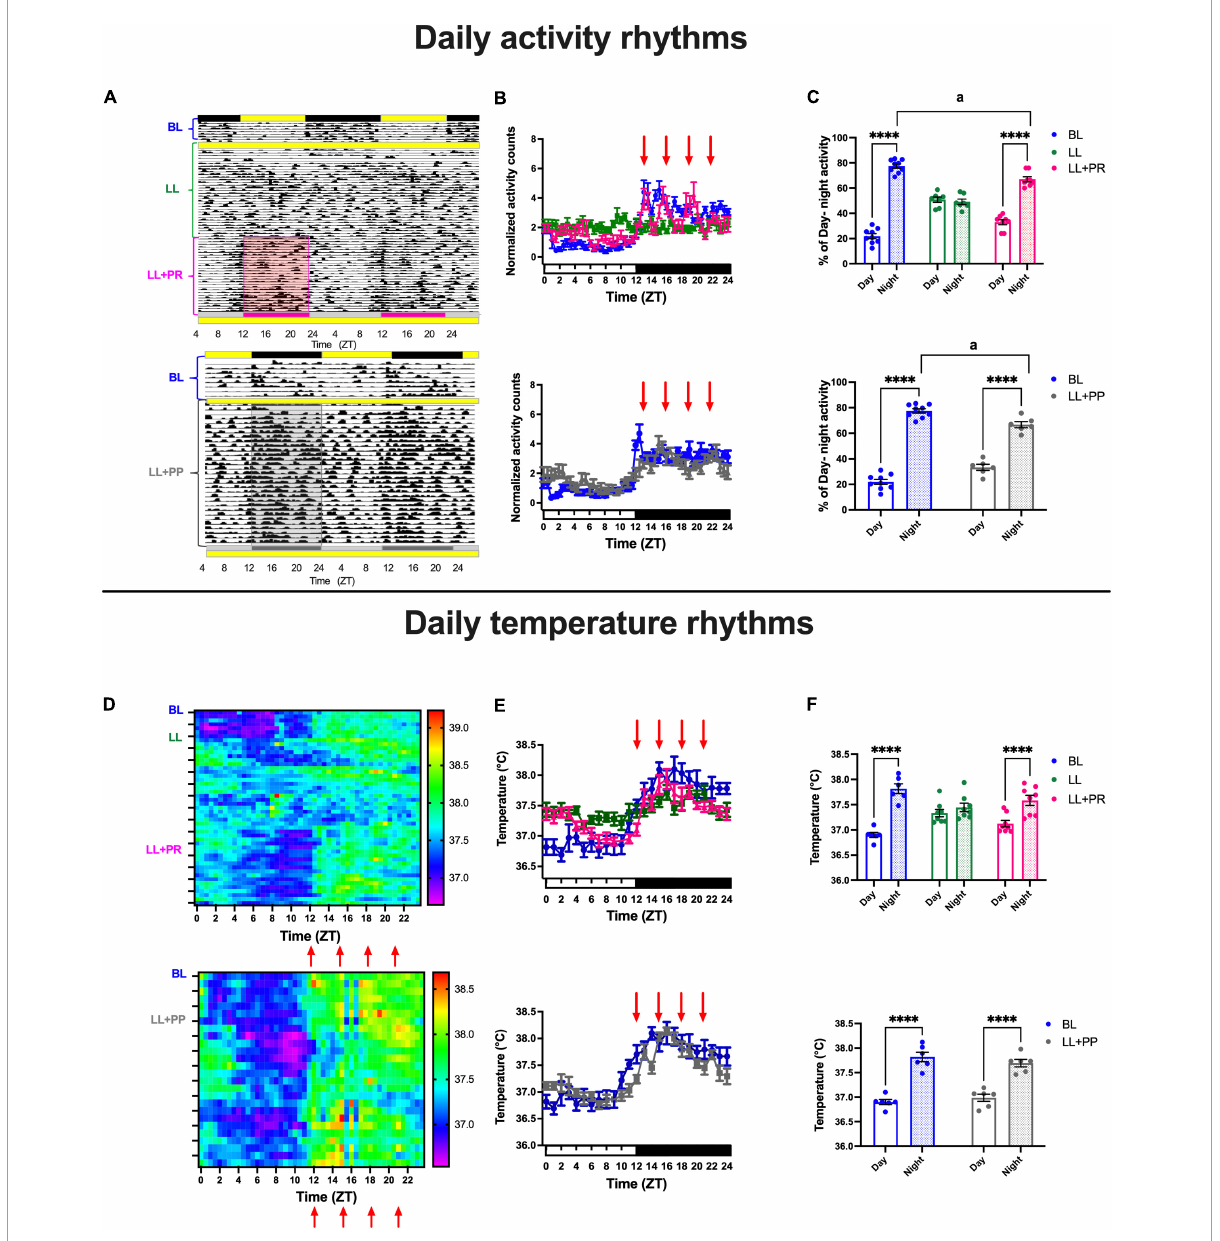
FIGURE6 Daily activity and core temperature cycles in rats exposed to a light–dark cycle during the baseline (BL, blue lines, and bars), to constant light (LL, green lines and green bars), to LL followed by 3 weeks of 12-h feeding protocol distributed in 4 pulses feeding events every 3 h as a rescue strategy (LL + PR, pink), or to LL simultaneously to 4 food pulses as a preventive strategy for 6 weeks (LL + PP). (A top) Representative actogram from the BL, LL, and the LL + PR condition. (A bottom) Representative actogram from the BL and the LL + PP condition. (B top and bottom) Mean daily activity profiles for the different experimental conditions: the four feeding pulses indicated by red arrows. Data are expressed as the mean ± SEM; n = 7–9/group. (C top and bottom) Day–night percentage of activity for the experimental stages. (D top) Mean heat map for the BL, LL, and LL + PR conditions. (D bottom) Mean heat map for the BL and LL + PP conditions. (E top and bottom) Daily temperature patterns for the different experimental conditions. Data are expressed as the mean ± SEM; n = 6–8/group. (F top) Day–night mean values for core temperature for the three experimental stages. (F bottom) Day–night mean values for core temperature for the two experimental stages of the LL + PP group, light bars represent day, and dashed bars represent night. Red arrows indicate the four events when food was placed in the feeder. Asterisks indicate a statistical difference between the day and the night value/group (**** P < 0.0001). For all graphs, light bars represent day (or subjective day) and dashed bars represent night (or subjective